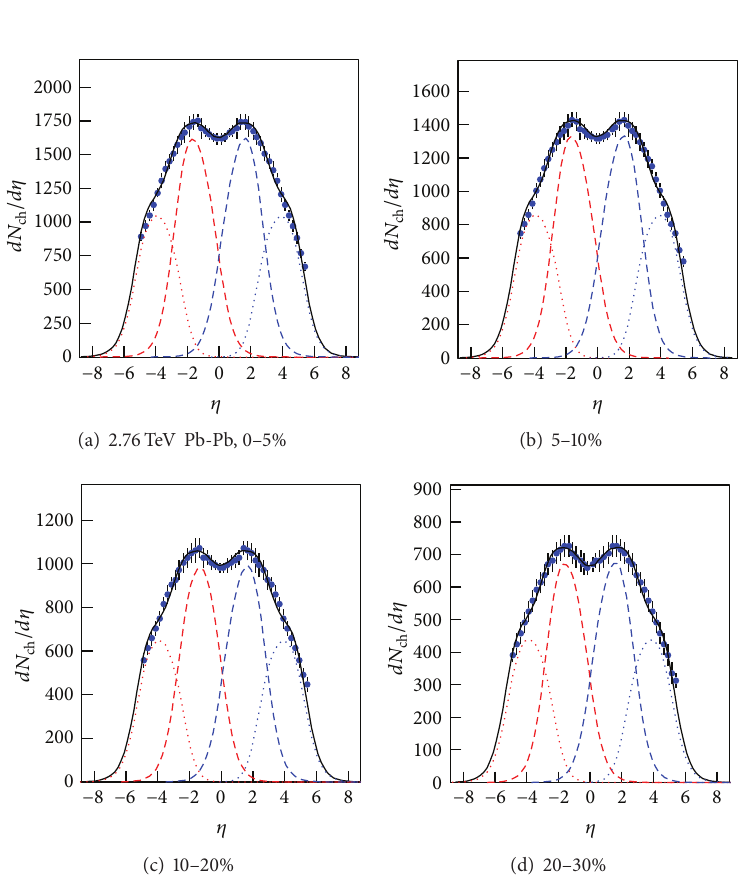
Figure 2: Pseudorapidity distributions of charged particles produced in Pb-Pb collisions at √𝑠 𝑁𝑁 = 2.76 TeV in the centrality intervals (a) 0–5%, (b) 5–10%, (c) 10–20%, and (d) 20–30%. The circles represent the experimental data of the ALICE Collaboration [9], and the curves are our modelling